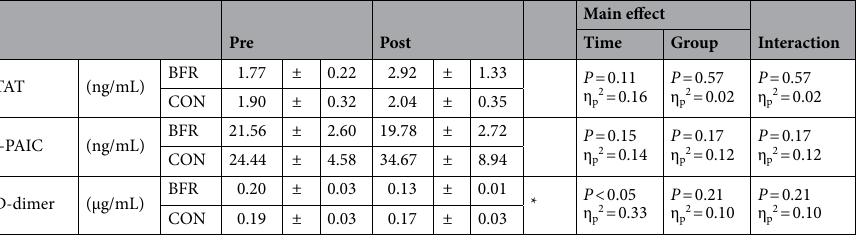
Table 3. Changes in thrombin/antithrombin III complex (TAT), tissue plasminogen activator/plasminogen activator inhibitor 1 complex (t-PAIC), and D-dimer before (Pre) and after (Post) 8-week cycle training with (BFR group) or without (CON group) blood flow restriction (BFR). Statistical analysis was performed using a repeated-measures two-way analysis of covariance followed by Bonferroni’s multiple comparisons test. Partial eta squared (η p2 ) is the effect size of the interaction and main effects of group and time. Values are expressed as mean ± SE (n = 9). *Significant difference from pre-training (Pre) ( P <